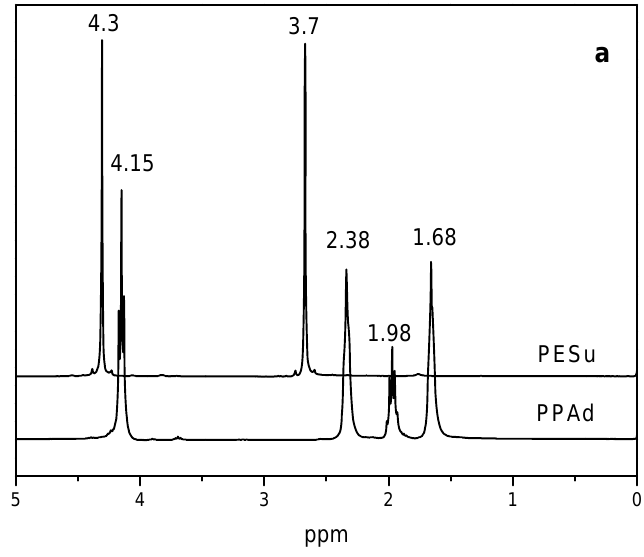
Figure 2. 1 H-NMR spectra of a) PESu, PPAd and b) their P(ESu-co-PAd)